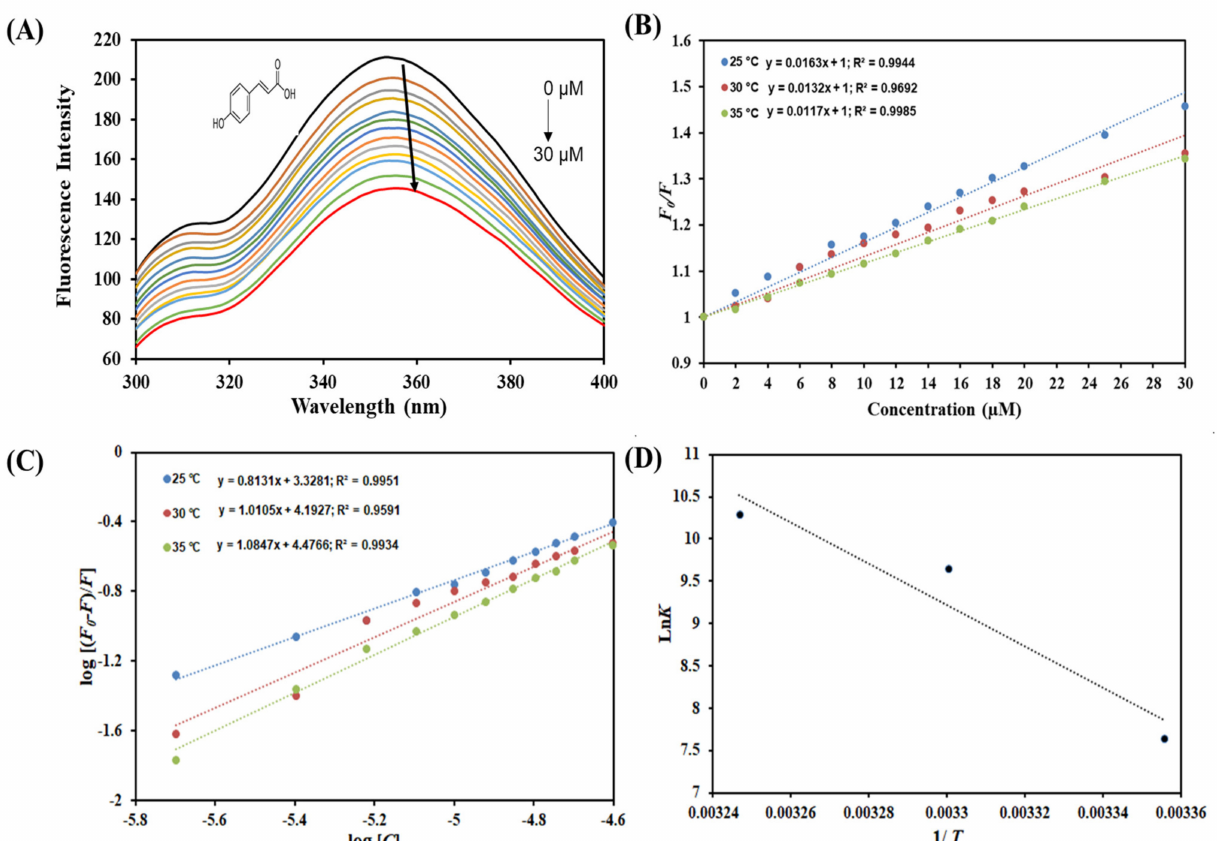
(Table 1) and α -amylase–coumaric acid (Table 2) were found to be higher than the maxi- mum dynamic quenching constant (nearly 10 10 M − 1 s − 1 ) [49]. Thus, it can be concluded that α -amylase–caffeic acid complex formation was driven by dynamic quenching while a combination of static and dynamic directs α -amylase–coumaric acid complex formation, while α -amylase–coumaric acid interaction was driven by static quenching. Additionally, the binding constant ( K ) was also calculated, revealing the binding affinity for protein (Table 2). Fluorescence quenching data were fitted into a modified Stern–Volmer equation with the intercept of the plot giving the value of binding constant ( K ) for both the ligands (Figures 1C and 2C). It was found to be of the order of 10 4 M − 1 for α -amylase–caffeic acid complex, while for α -amylase–coumaric acid, K was of the order of 10 4 M − 1 , but lesser than caffeic acid, suggesting that caffeic acid binds to α -amylase with a higher affinity as compared to coumaric acid. Table 1 depicts the values of K at different temperatures for α -amylase–caffeic acid complex, which was found to decrease with increasing temperature, implying that a more stable complex is formed at lower temperatures. Table 2 depicts the values of K obtained for α -amylase–coumaric acid complex.